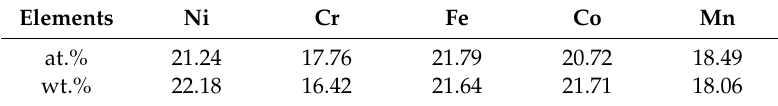
Table 1. Chemical composition of the NiCrFeCoMn high-entropy alloy (HEA). Elements Ni Cr Fe Co Mn